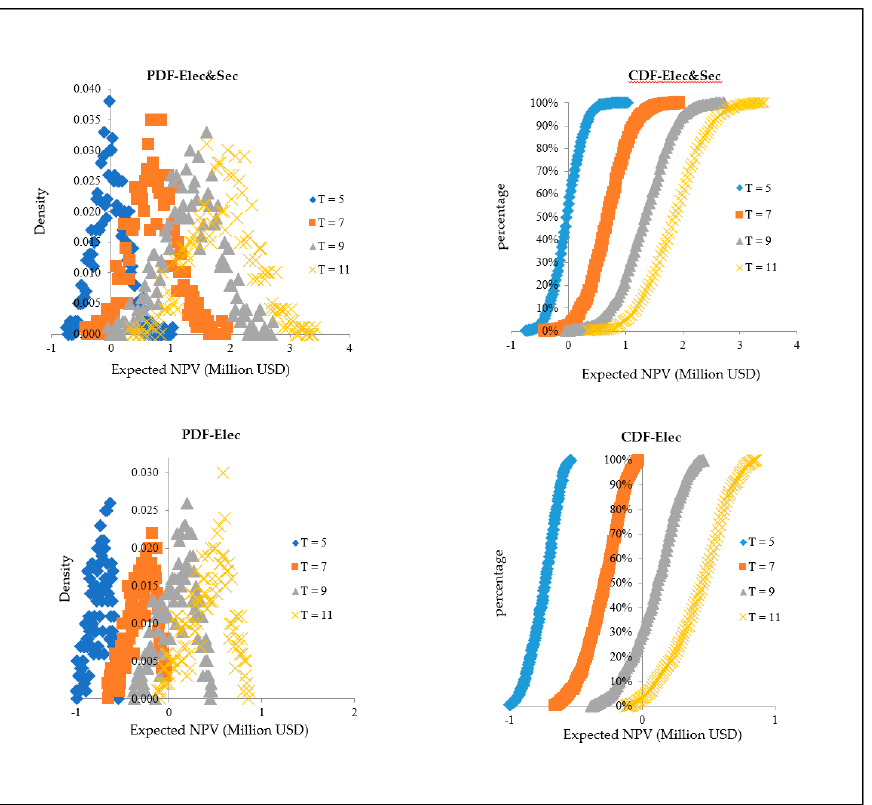
Figure 10. The probability distributions of the NPV (source: authors calculation, using Crystal Ball software).